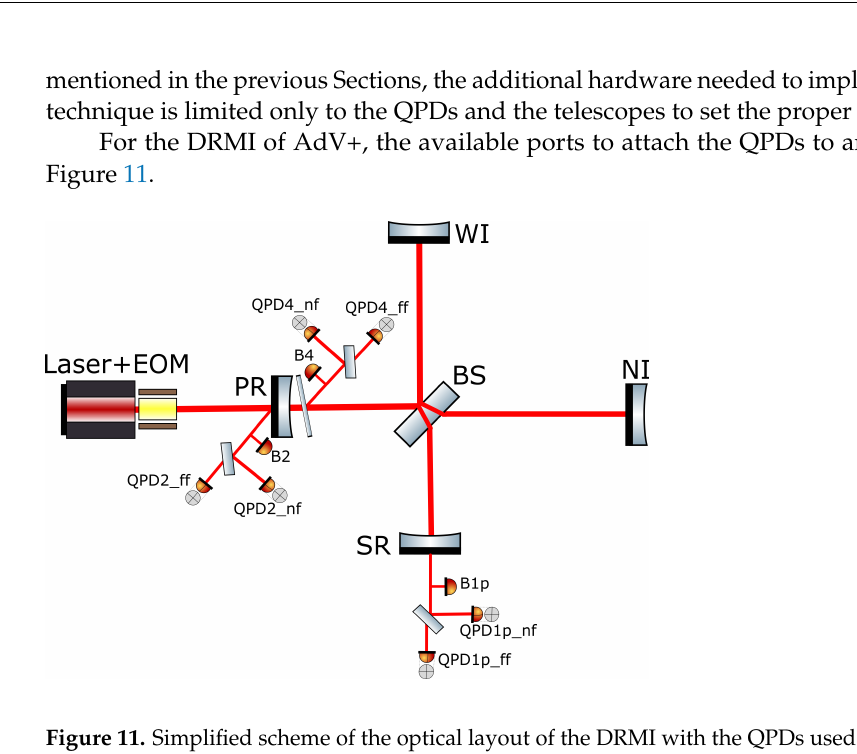
Figure 11. Simplified scheme of the optical layout of the DRMI with the QPDs used for the automatic alignment